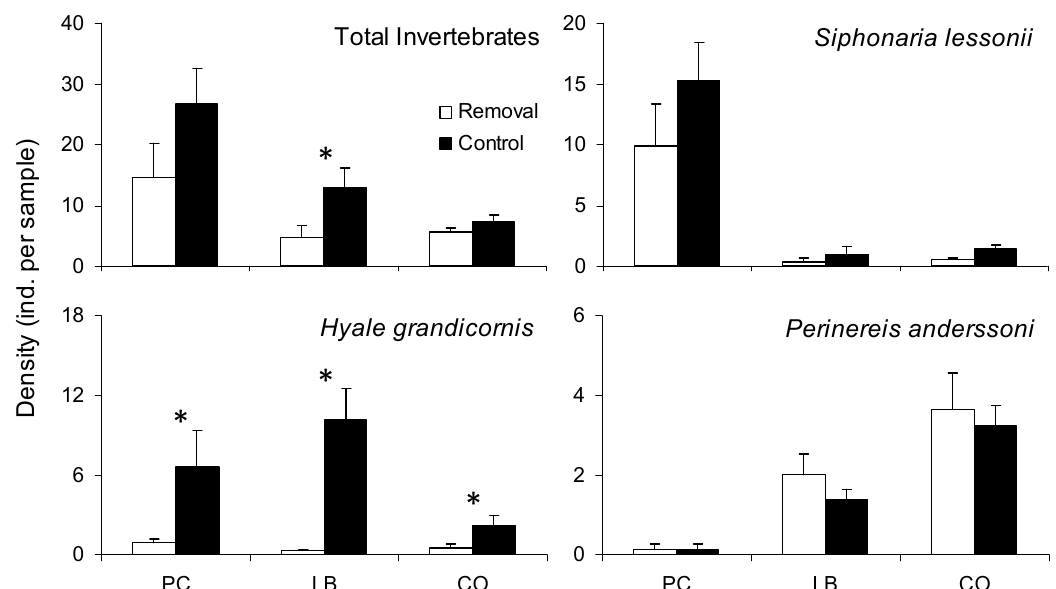
Figure 5. Mean (SE) total invertebrate density and densities of common species (i.e., species present at all sites at mean overall densities in excess of 1 individual per sample) in the Porphyra -removal treatment and control plots with natural Porphyra cover. Experiments were conducted during December–January when Porphyra cover peaks (60–80% cover) and at three sites/dates: Punta Cantera/2011 (PC), Las Brusquitas/2015 (LB), and Copacabana/2017 (CO). Asterisks indicate significant different between treatments at a site/date.